Question: Describe this figure in one sentence.
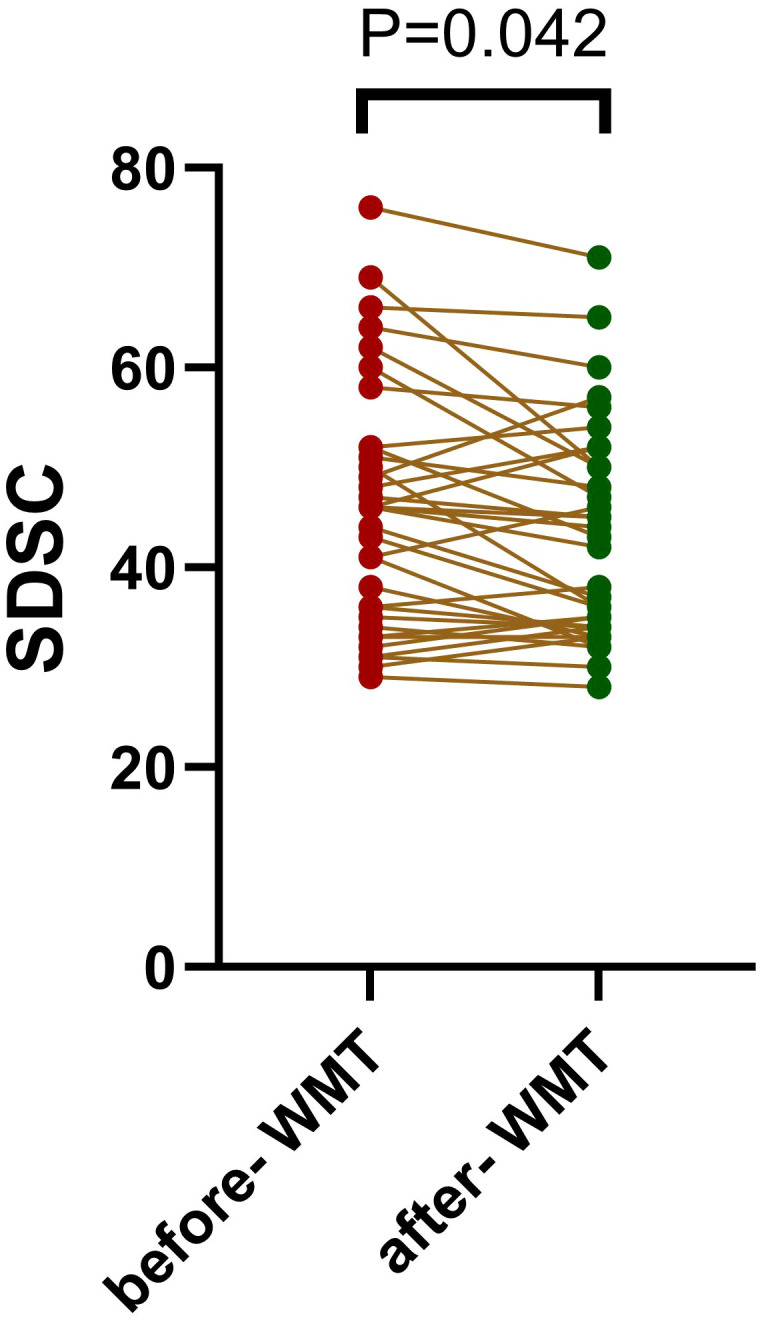
Answer: Comparison of changes in SDSC scale scores in children with ASD before and after single-donor WMT.